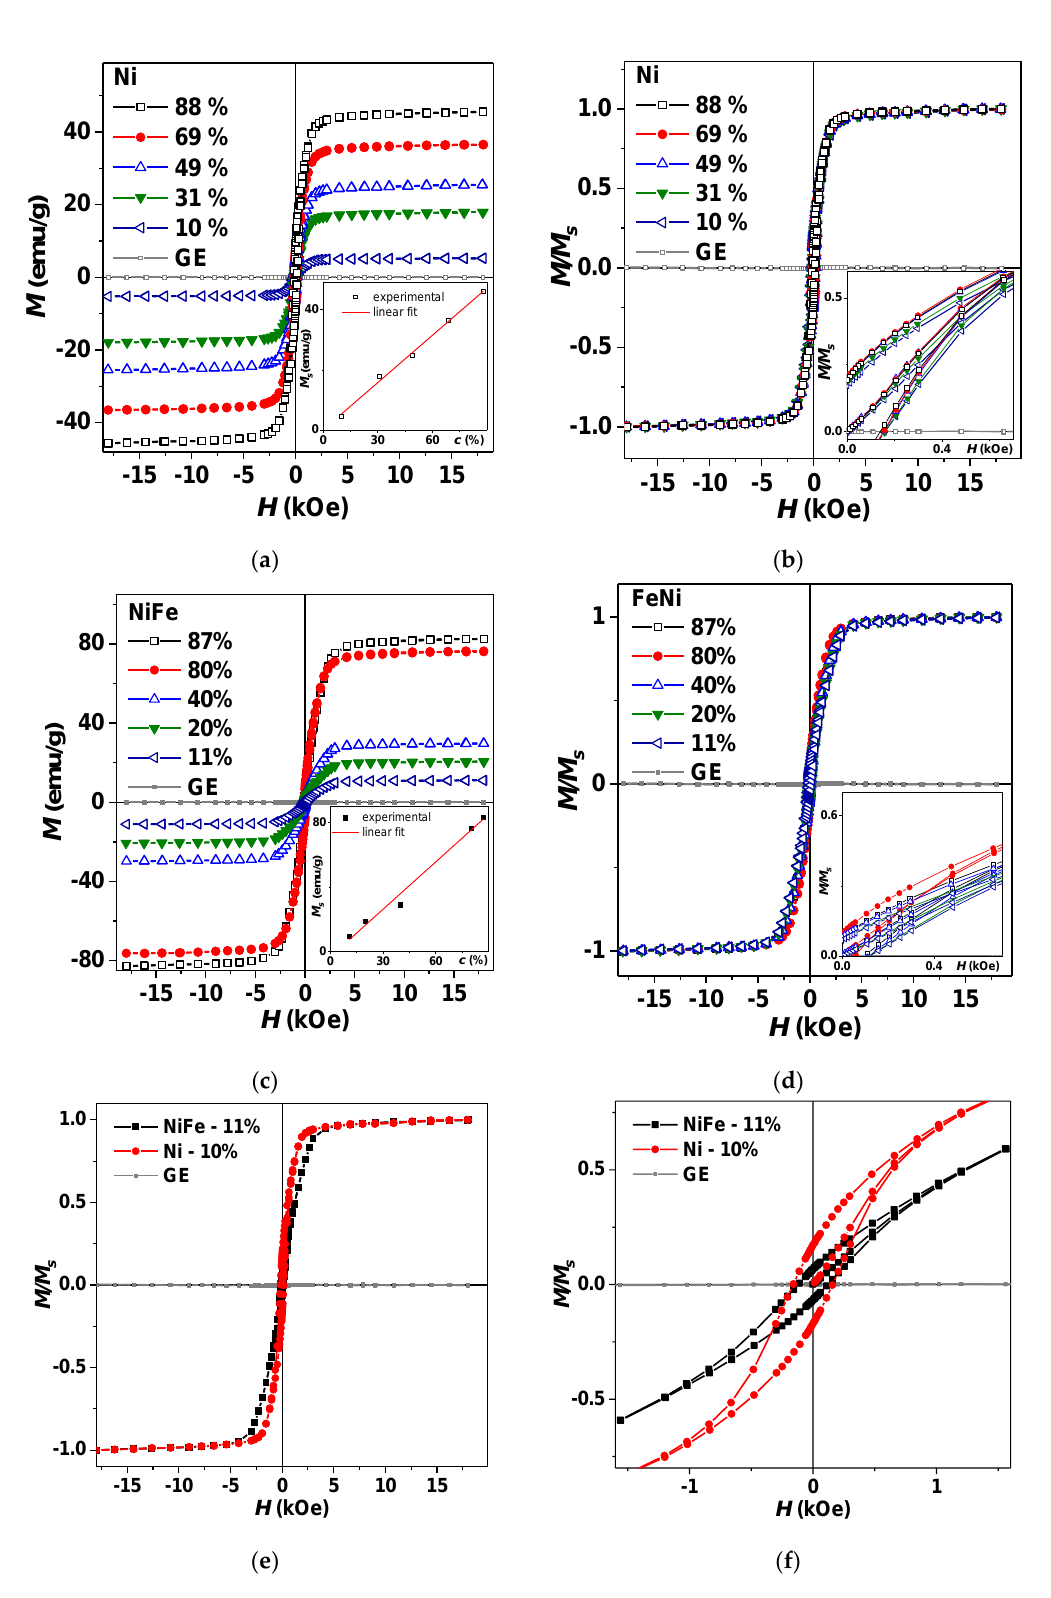
Figure 7. Magnetic hysteresis loops of GE/Ni ( a , b ) and GE/Ni82Fe18 ( c , d ) composites. Inset ( a ) shows the M s dependence on the concentration of Ni MNPs; inset ( b ) shows the low field part of the hysteresis loop for GE/Ni; inset ( c ) shows the M s dependence on the concentration c of NiFe MNPs; inset ( d ) shows the low field part of the M(H) loop for GE/Ni82Fe18 composites. Hysteresis loops of relative magnetization for GE/Ni and GE/Ni82Fe18 composites ( e , f ).